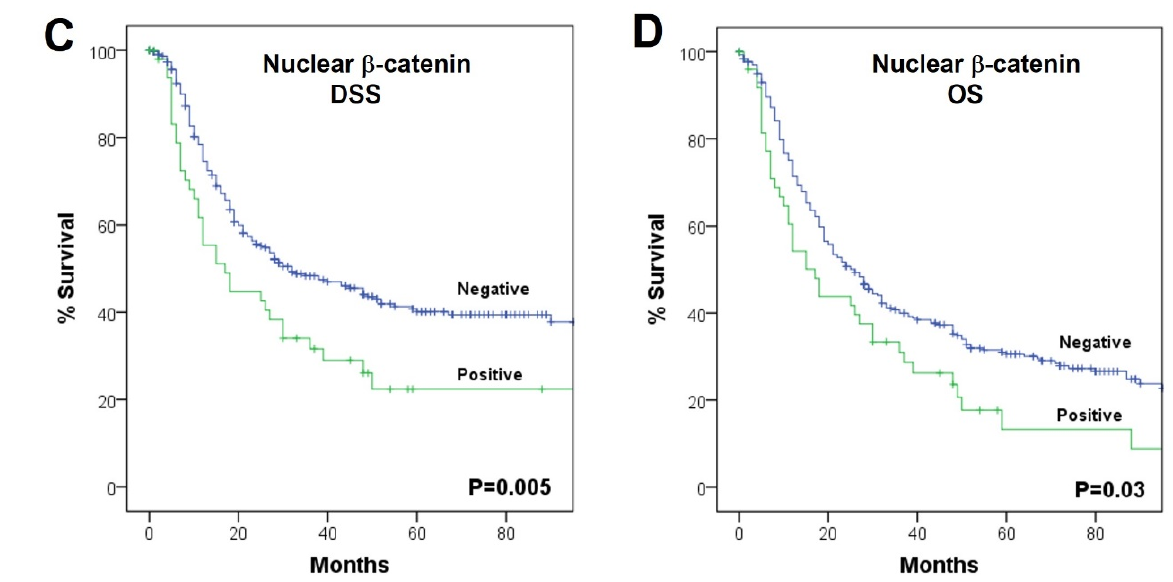
Figure 2. Kaplan–Meier-disease-specific (left) and overall survival (right) curves according to the expression of membrane β -catenin ( A , B ) and nuclear β -catenin ( C , D ). p -values were estimated using the Log-rank test.